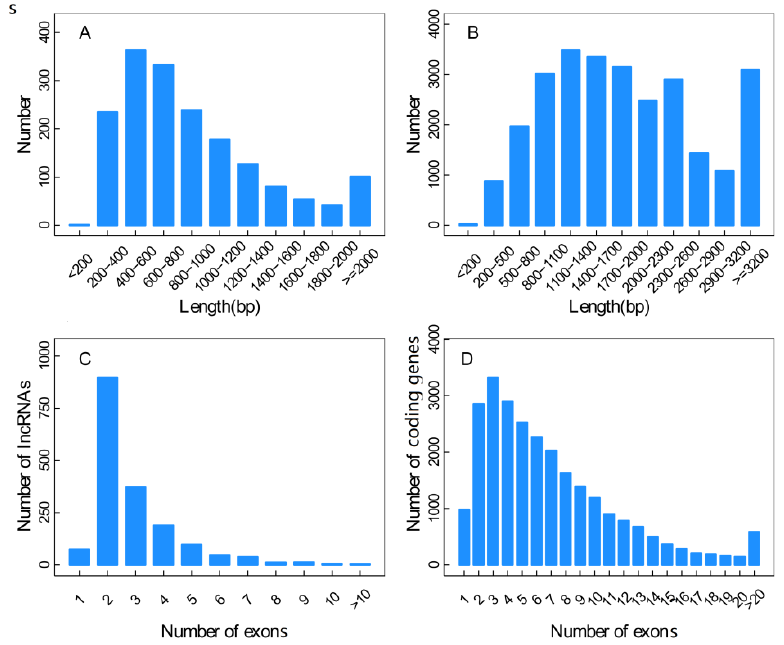
Figure 5. Sequence features of lncRNAs. ( A ) and ( B ) represented the length distributions of the transcripts from novel lncRNAs ( A ) and known coding genes ( B ); (C) and (D) represented the exon numbers of the transcripts of lncRNAs ( C ) and known coding genes ( D ).